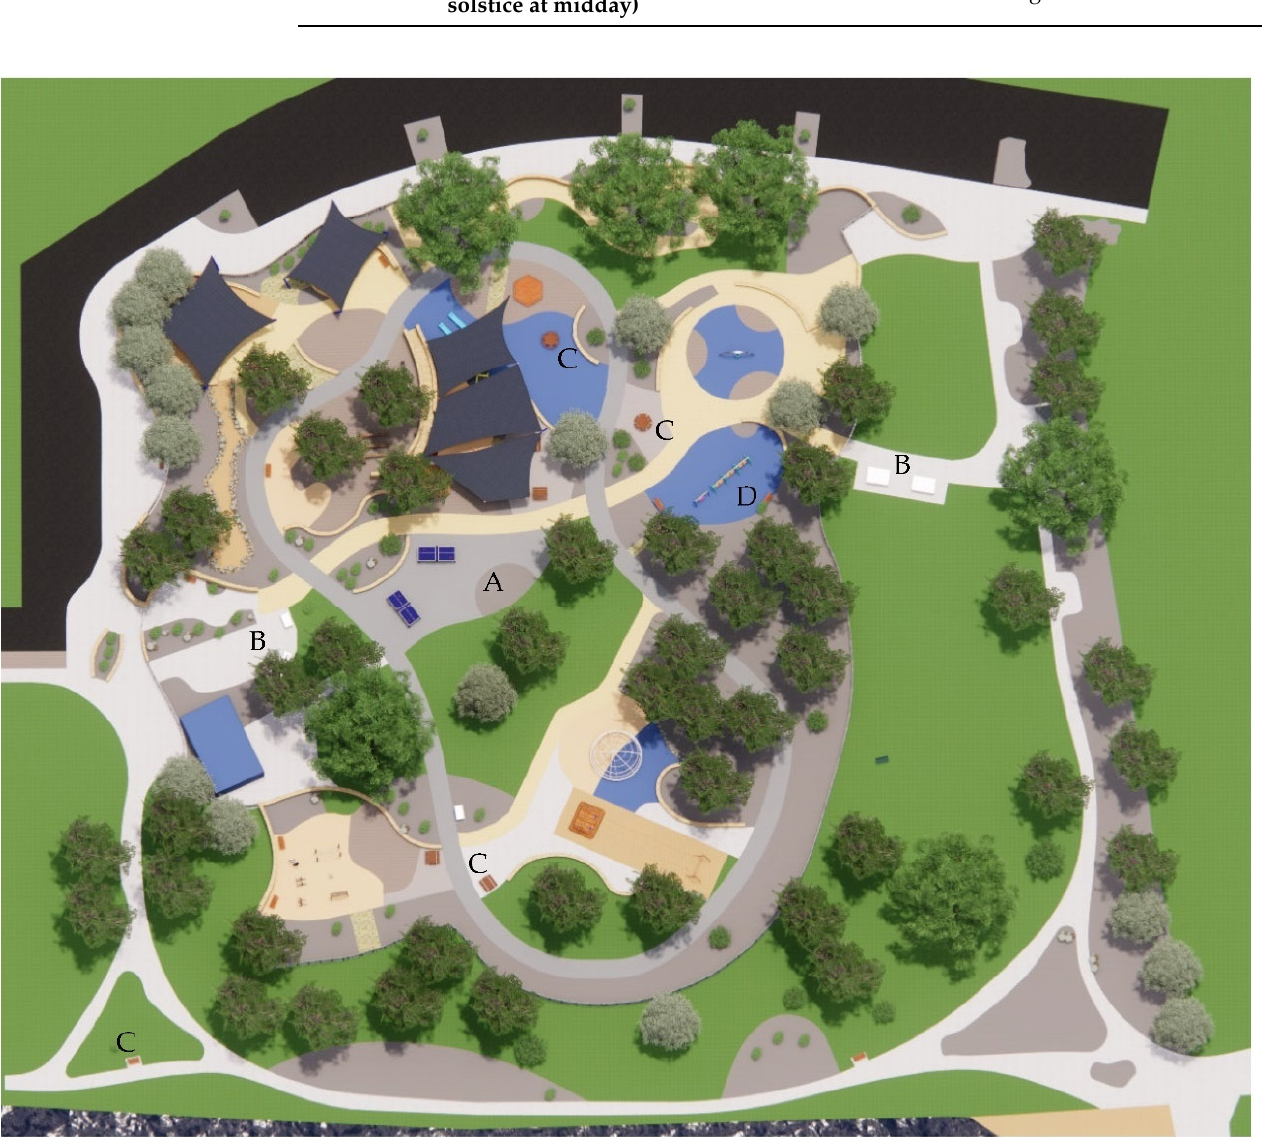
Figure 13. Shade sail, swings, and unshaded seating areas during midday on the summer solstice. Shadow Analysis simulations depicting the average number of hours (per day) in shade.